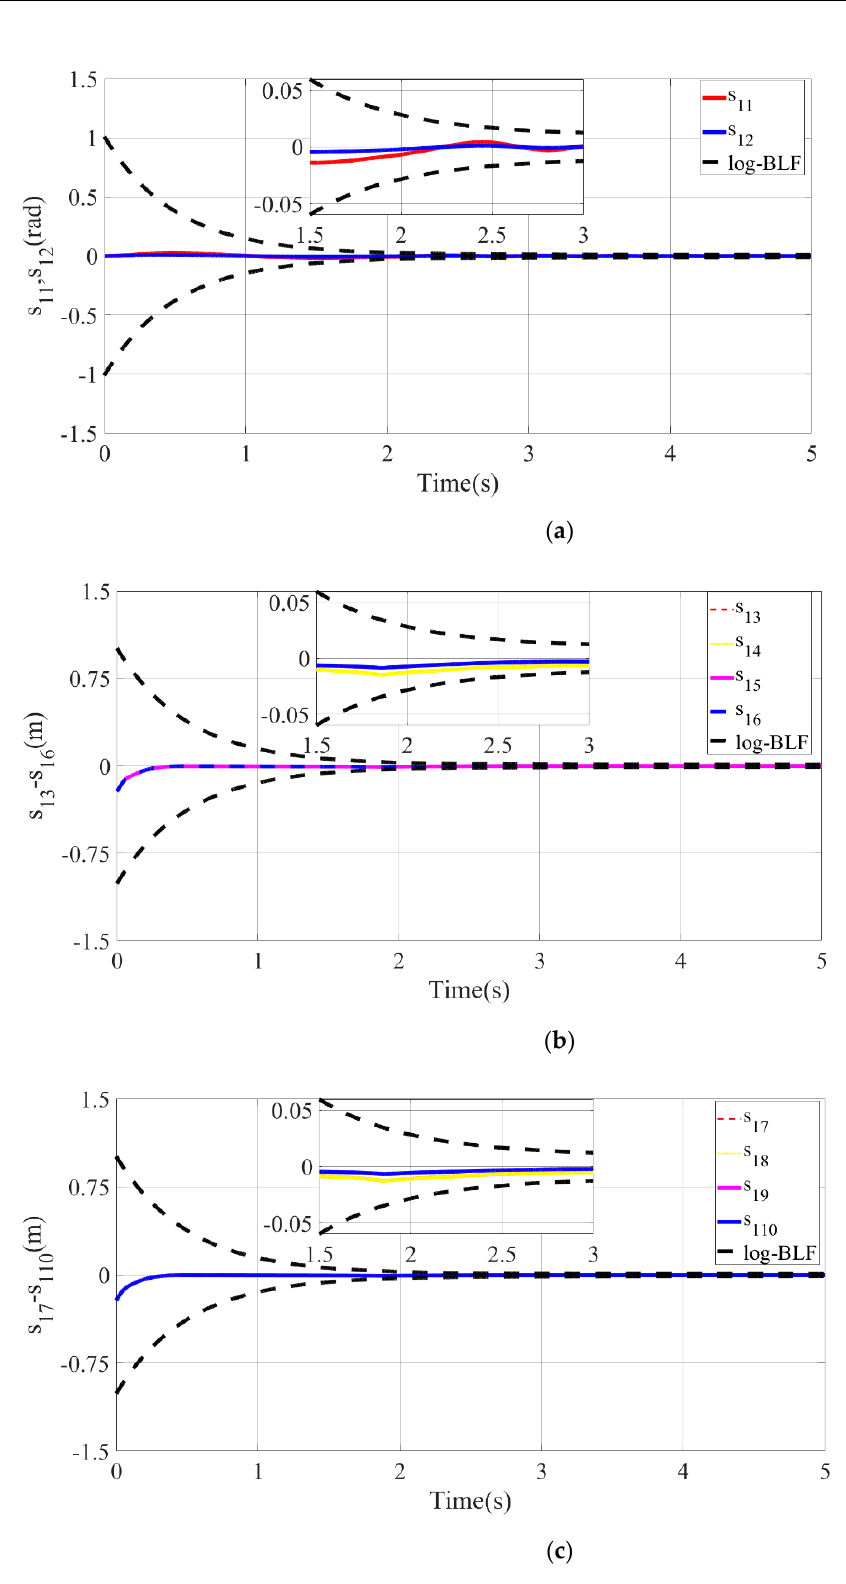
Figure 13. Iterative convergence curve of each joint-position tracking. ( a ) Angle-tracking error of SCARA manipulator in the joint space. ( b ) Position-tracking error of PMA1-4. ( c ) Position-tracking error of PMA5 ‐ 8.